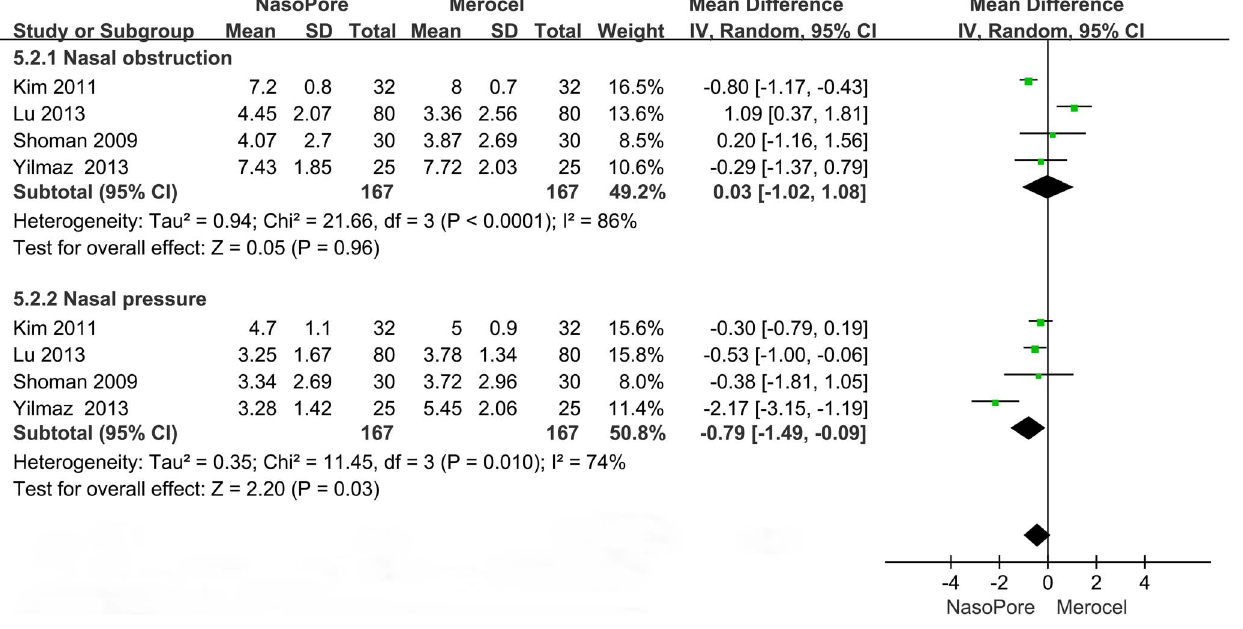
Figure 5. Forest plots of MD and 95% CI for nasal obstruction and pressure.